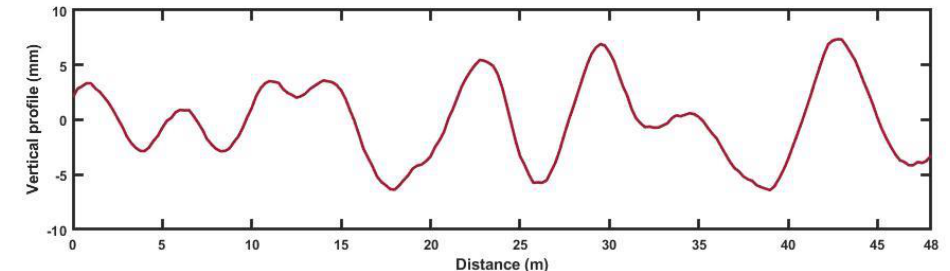
Figure 2. The profile of track irregularities (vertical rail levels).